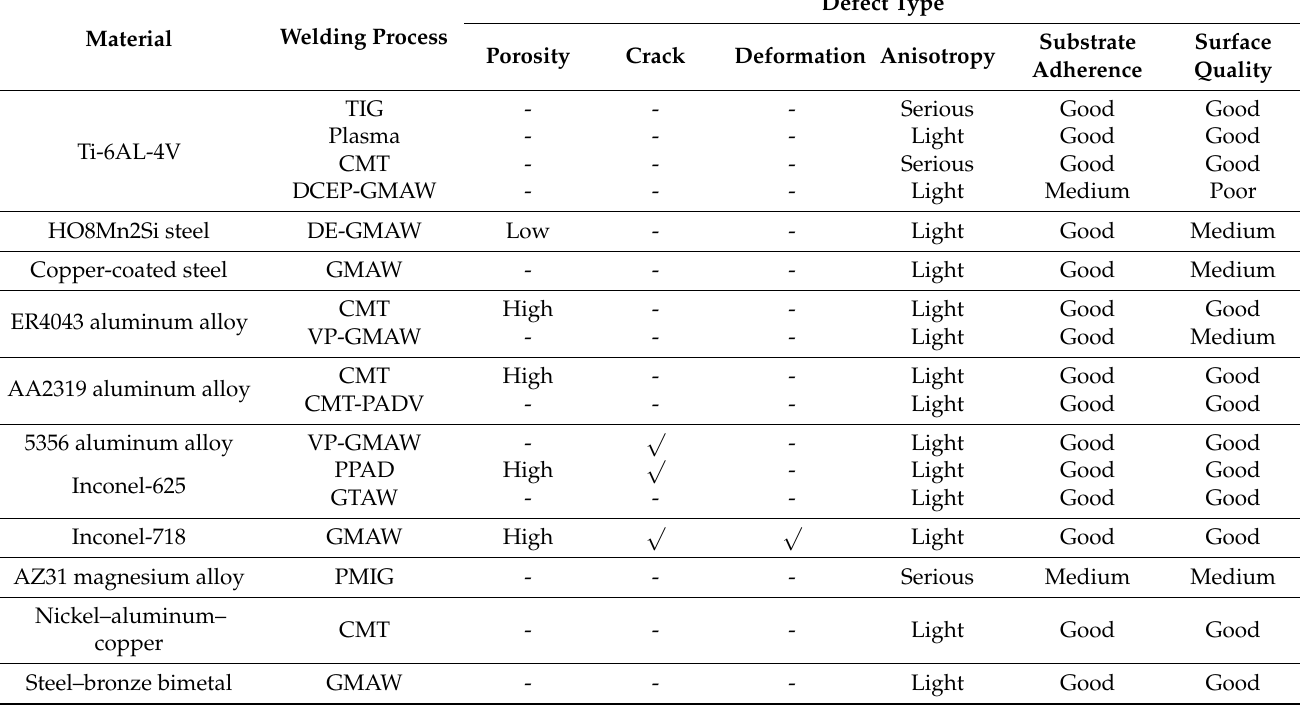
Table 2. Defects in WAAM